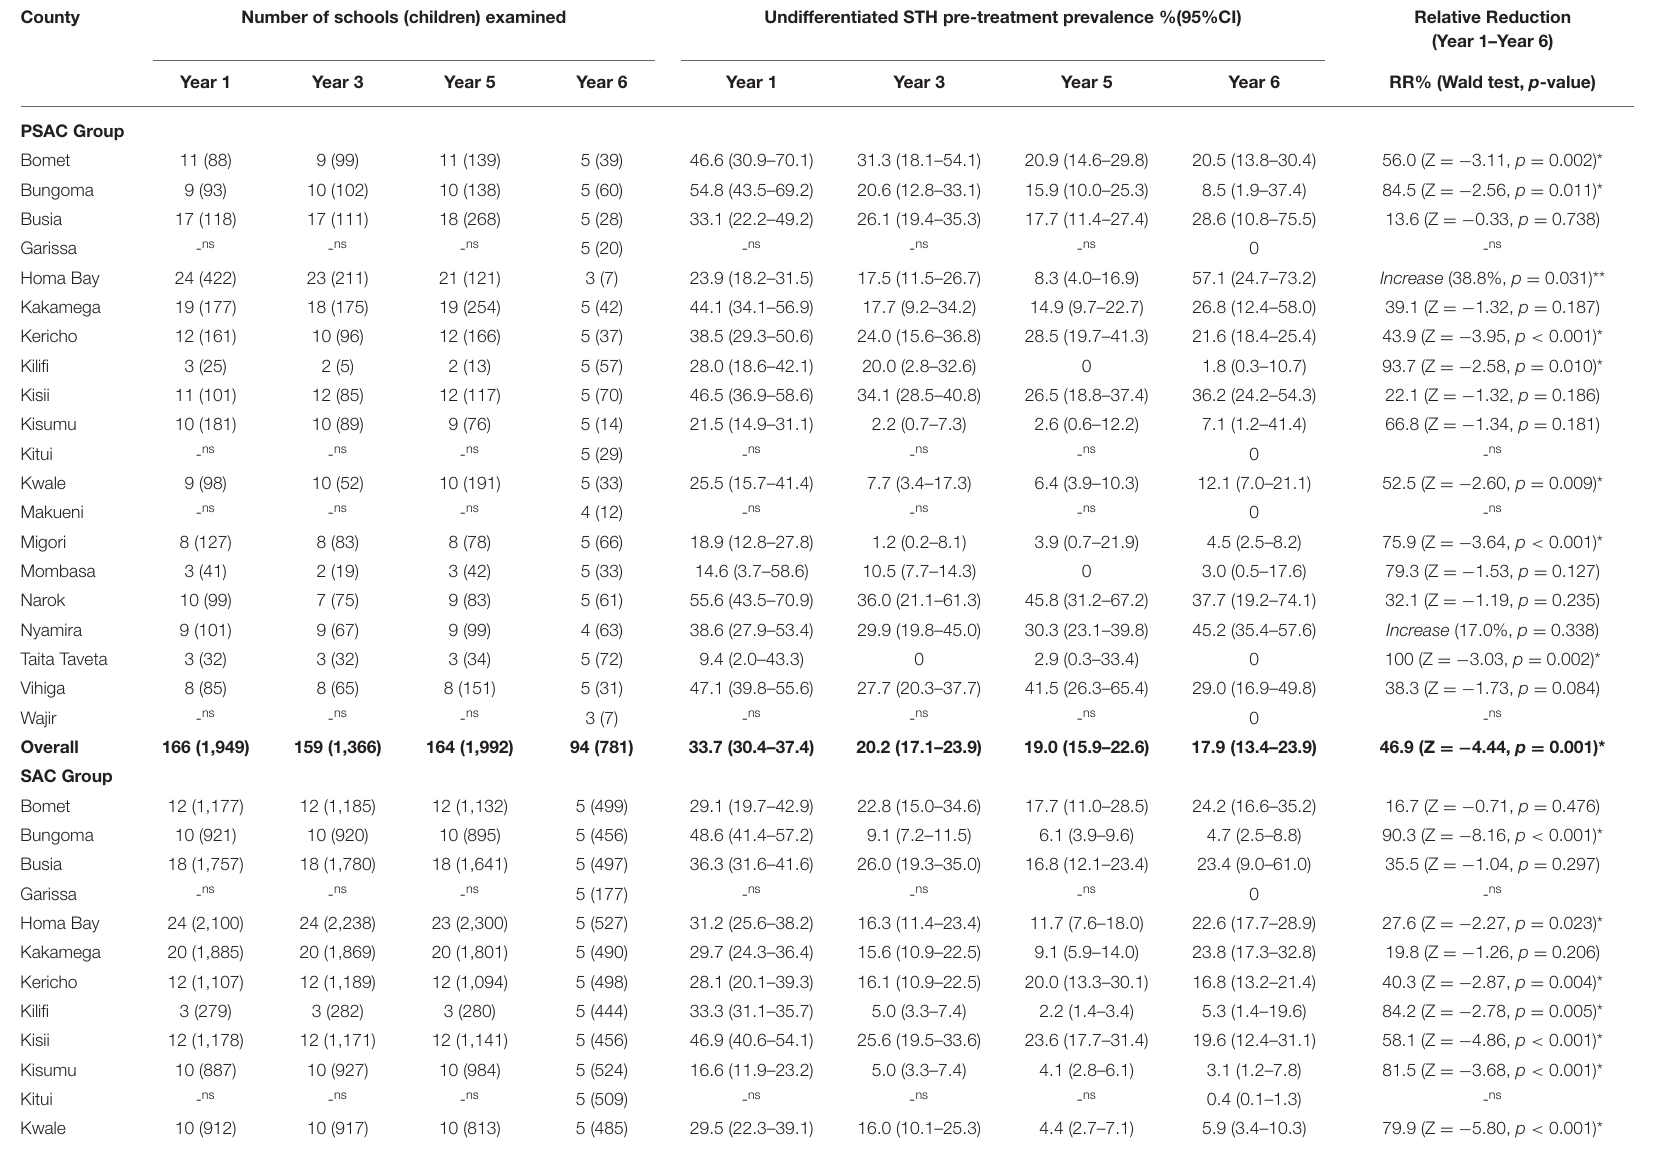
TABLE 1 | Number of schools (children) examined, undifferentiated STH pre-treatment prevalence % (95% CI), and relative reductions % (Wald test: Z-statistic, p -value) by county for preschool (PSAC) and school (SAC) aged group of children in 20 counties in Kenya.